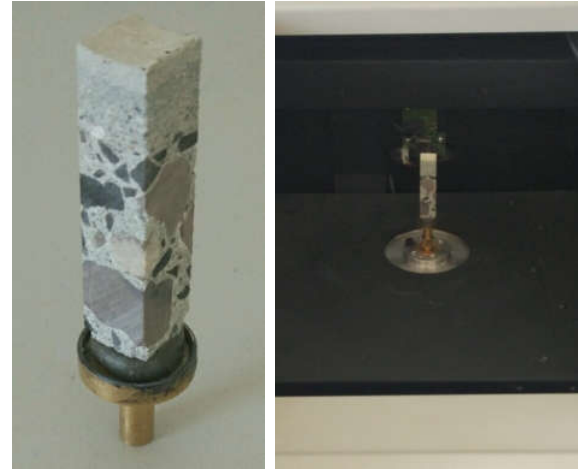
Figure 27. Sample mounted on base and placed in microtomograph chamber.